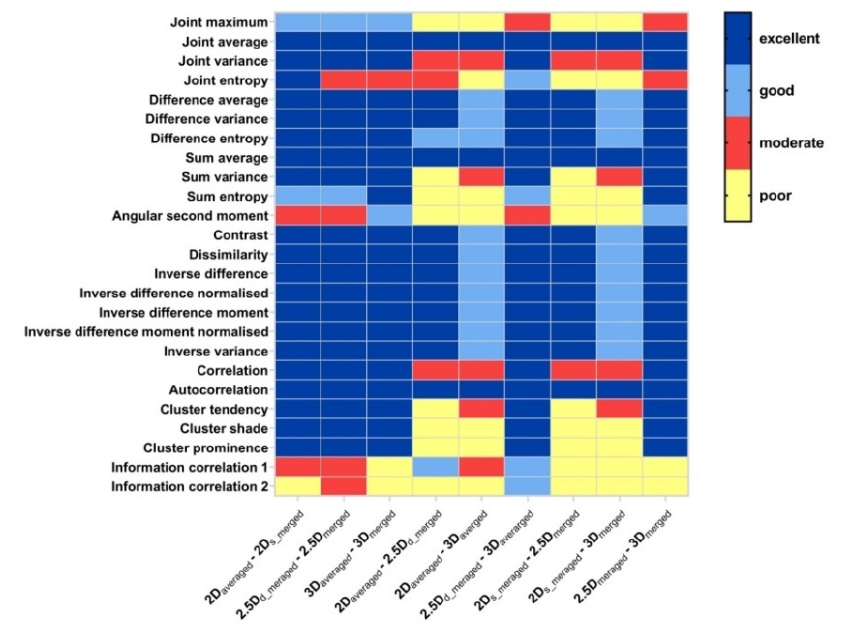
Figure 3. ICC heat map of GLCM features; volumes: pair-wise aggregation methods corresponding